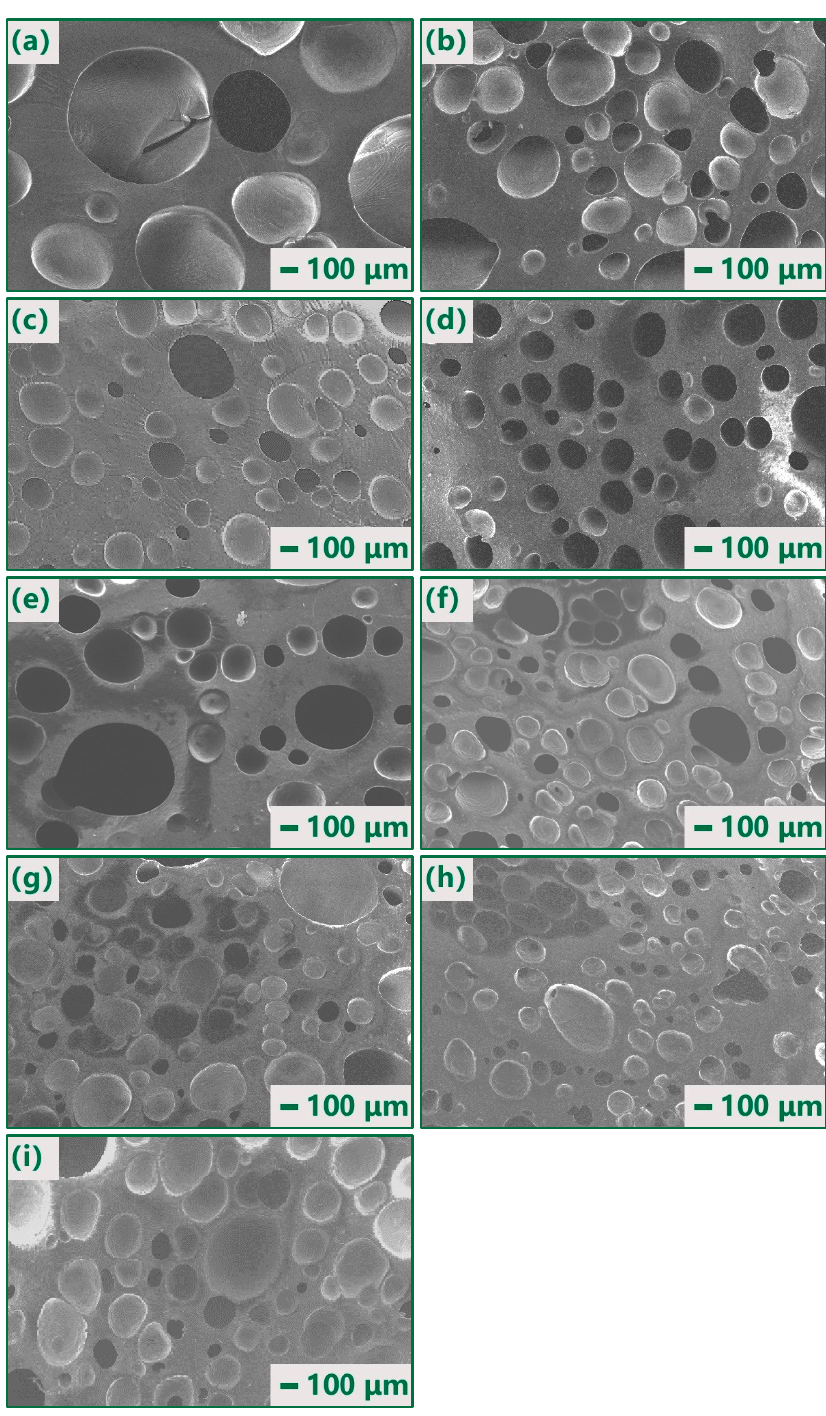
Figure 3. Cell structure of the composites of various expansion rates and Gr contents: ( a ) 0 wt%, F2; ( b ) 1 wt%, F2; ( c ) 2 wt%, F2; ( d ) 3 wt%, F2; ( e ) 4 wt%, F2; ( f ) 3 wt%, F3; ( g ) 3 wt%, F4; ( h ) 3 wt%, F5; ( i ) 3 wt%, F2-5.